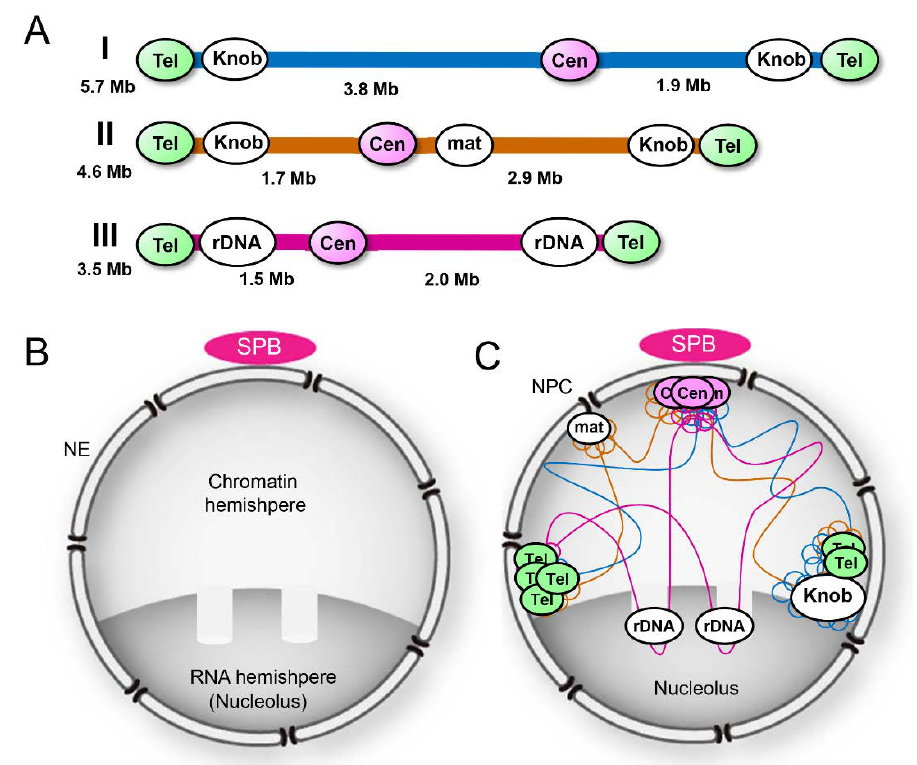
Figure 1. The overall structure of the Schizosaccharomyces pombe nucleus. ( A ) Genomic organization of S. pombe chromosomes. Cen, centromere; Tel, telomere; mat, mat locus; and rDNA, repeat sequences coding ribosomal RNA. ( B ) S. pombe nucleus: A chromatin hemisphere and an RNA hemisphere with two protrusions of chromatin. ( C ) Spatial organization of chromosomes in the nucleus.